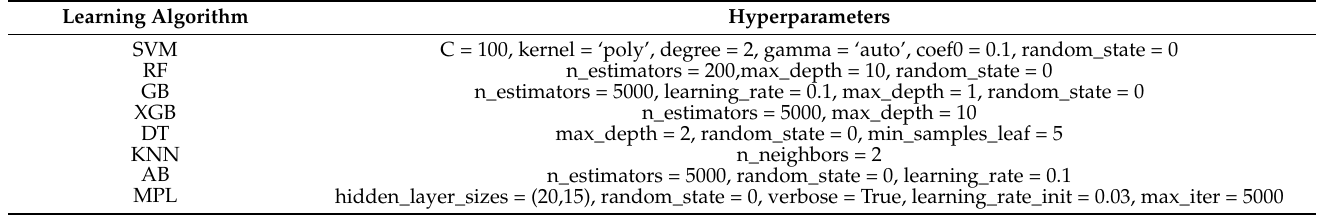
Table 7. The set hyperparameters for each learning method.